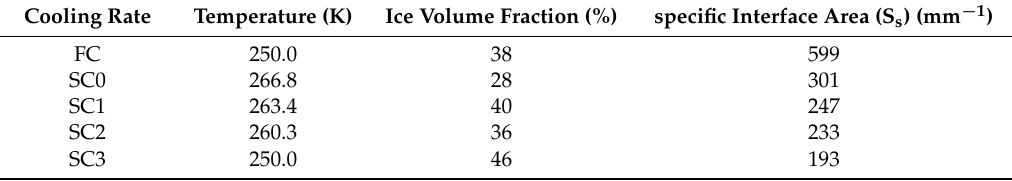
Table 1. The total volume fraction and specific interface area (S s ) of ice crystals quantified by 3D tomography.